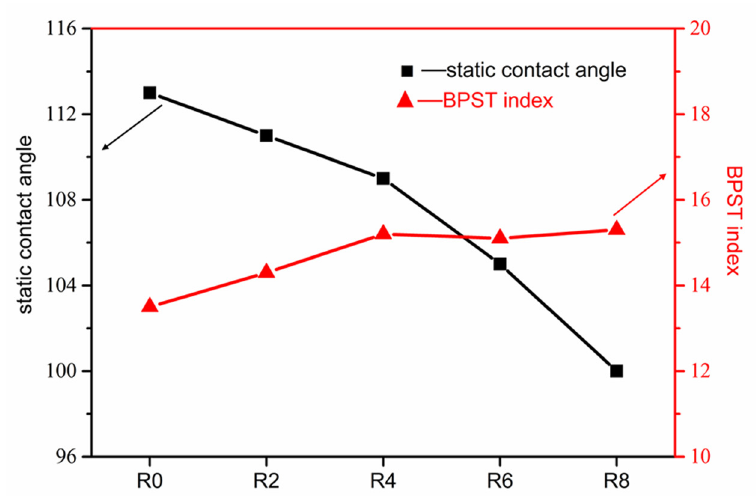
Figure 8. Water contact angles and British Pendulum Skid Tester (BPST) values of the Figure 8. water contact angles and British Pendulum Skid Tester (BPST) values of the vulcanizates.